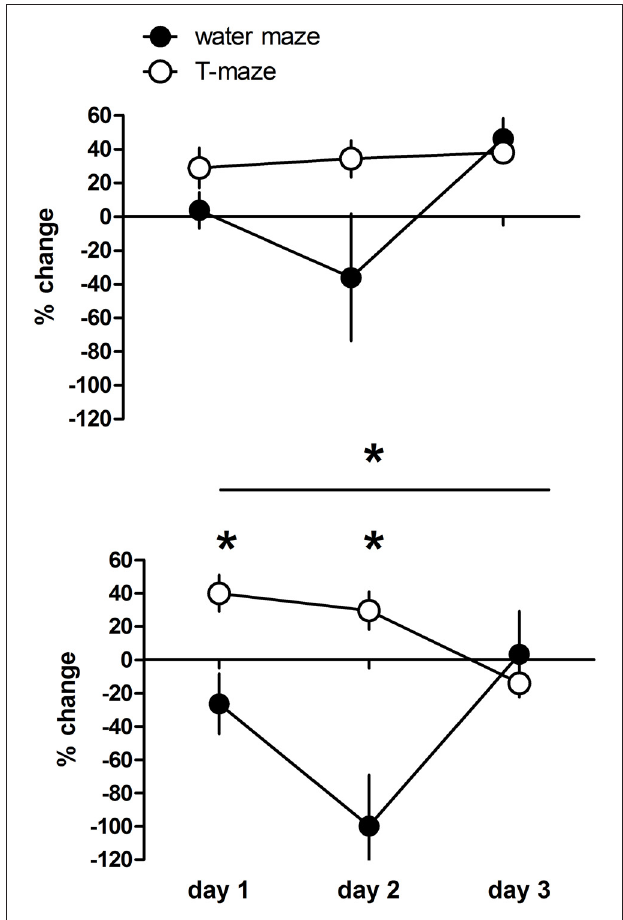
FIGURE 3 | Changes in working memory indices (T-maze) and escape latencies (water maze) expressed as variation in percentage from the mean value (100%) of the respective control group of individual D1R-like agonist treated rats at a dose of 1 µ g or 5 µ g. Positive values indicate improvement and negative deterioration of working memory. Significant differences between groups over the entire training are indicated by an asterisk above horizontal bars. Significant differences between groups for specific days are indicated by asterisks above daily data points. Given are the mean values and